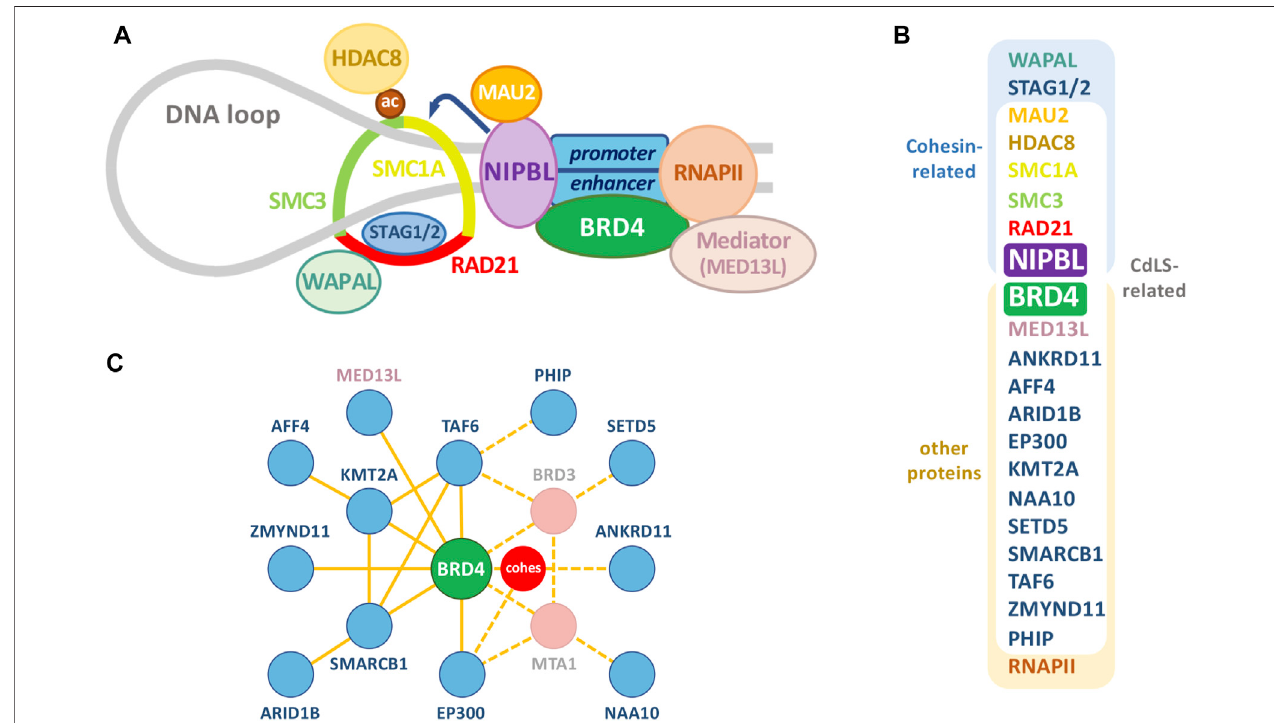
FIGURE 1 | The cohesin complex and associated proteins. (A) Relevant proteins of the cohesin complex and other chromatin-associated proteins. Besides RNA polymeraseII(RNAPII)andclassicalCdLS-relatedproteins, selectedNIPBL-BRD4commoninteractors,likeothercohesin-relatedproteinsandMediator(see Figure3 ), have been depicted. (B) Proteins in (A) , together with additional factors associated with a CdLS-like phenotype, are classi fi ed as cohesin-related and/or CdLS-related. (C) Interactome of the additional factors associated with a CdLS-like phenotype (blue) with BRD4 (green) occupying a central position. Dashed lines indicate putativewaysofindirectassociationwithBRD4throughtheproteinsindicatedinpinkorthecohesincomplex(red).DiagramwasderivedfromanesyNtool(http://www. esyn.org/) representation based on BioGRID data.